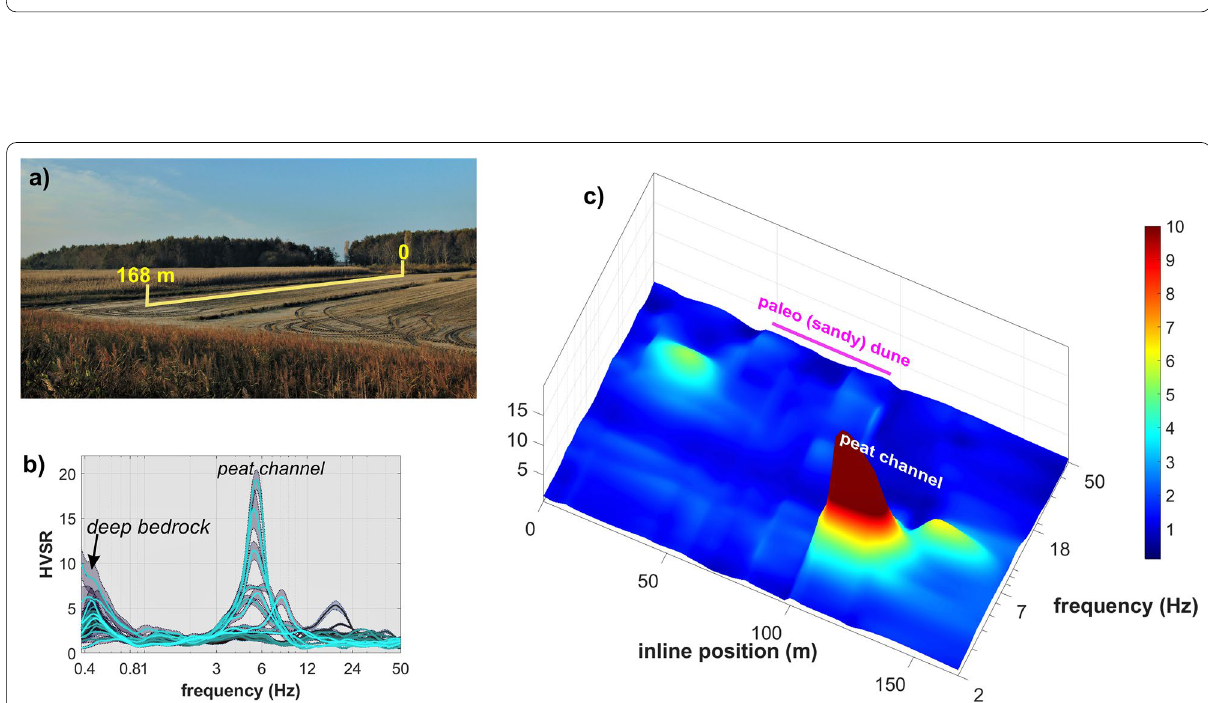
Fig. 19 Aerial view of the Beligna#2 residual dune. The lighter colours are due to shallow sandy materials while darker colours to finer (silty) alluvia sediments (see the similar conditions of the Beligna#1 area—Fig. 9a). Due to the intensive agricultural activity, DTM data does not show any evidence of such a paleo dune (Fig. 2a)